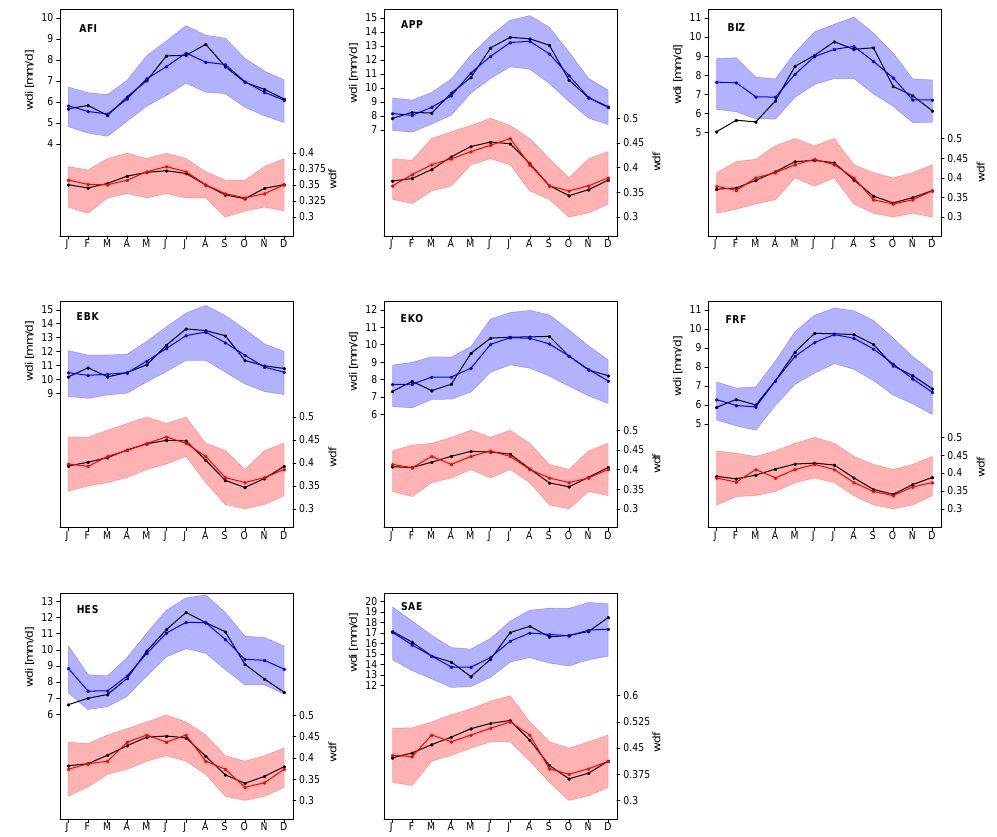
Figure 4. Observed and modelled monthly mean wet day intensity (blue) and frequency (red) at eight stations during 1961–2011. The black (coloured) lines indicate the observed (modelled) values. The blue (red) shaded areas correspond to the inter-quartile range across the set of synthetic daily time series. They comprise 100 runs covering every 51